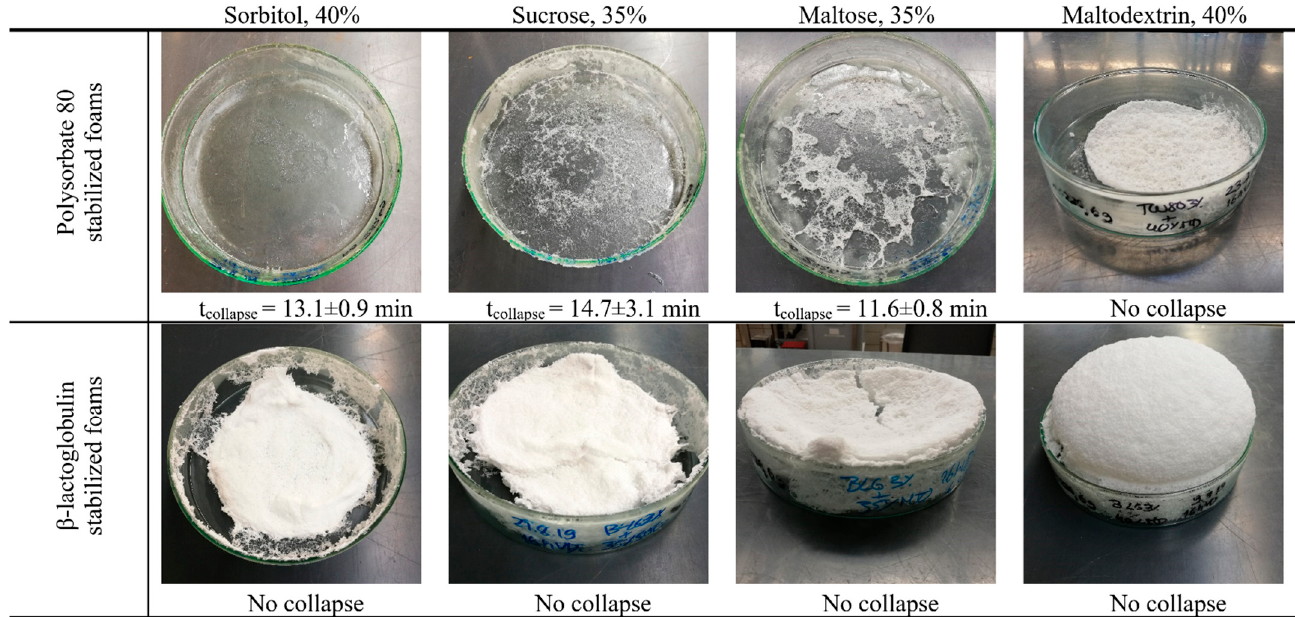
Figure 6. Impact of sugar types on the foam decay in conventional vacuum drying with regard to the used foaming agents and saccharides.